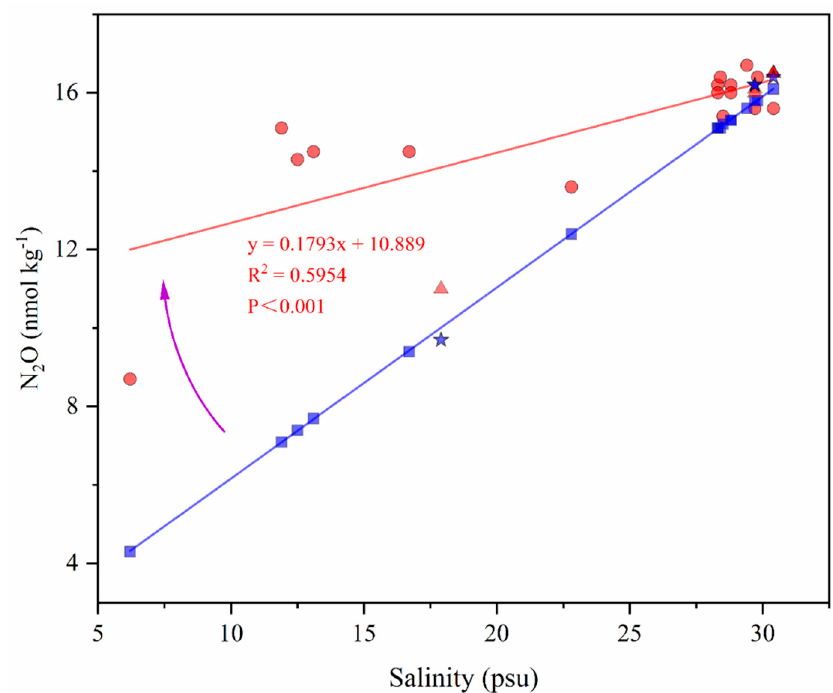
Figure 6. Observed N 2 O (red) and T ‐ N 2 O USW (blue) concentration versus salinity in USW. The red circles and triangles represent the observed N 2 O for MYI and FYI, respectively; the blue rectangles and pentacles represent the T ‐ N 2 O USW for MYI and FYI, respectively.